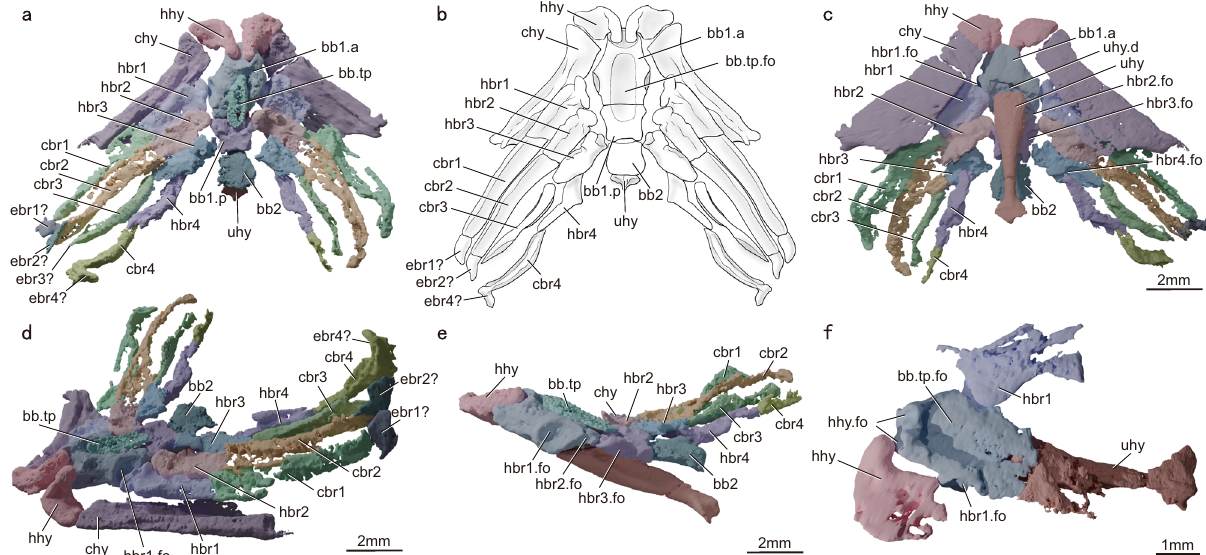
Fig. 3 Ventral portion of the hyoid arch and gill skeleton of Youngolepis praecursor . a Virtual rendering of V28375 in dorsal view. b Interpretive drawing of V28375 in dorsal view. c Virtual rendering of V28375 in ventral view. d Virtual rendering of V28375 in antero-dorsal-lateral view. e Virtual rendering of V28375 in lateral view. f Virtual rendering of V28376 in dorsal view. bb1.a anterior half of basibranchial 1, bb1.p posterior half of basibranchial 1, bb2 basibranchial 2, bb.tp basibranchial toothplate, bb.tp.fo fossa for the basibranchial toothplate, cbr1 – 4 ceratobranchials 1 – 4, chy ceratohyal, ebr1 –